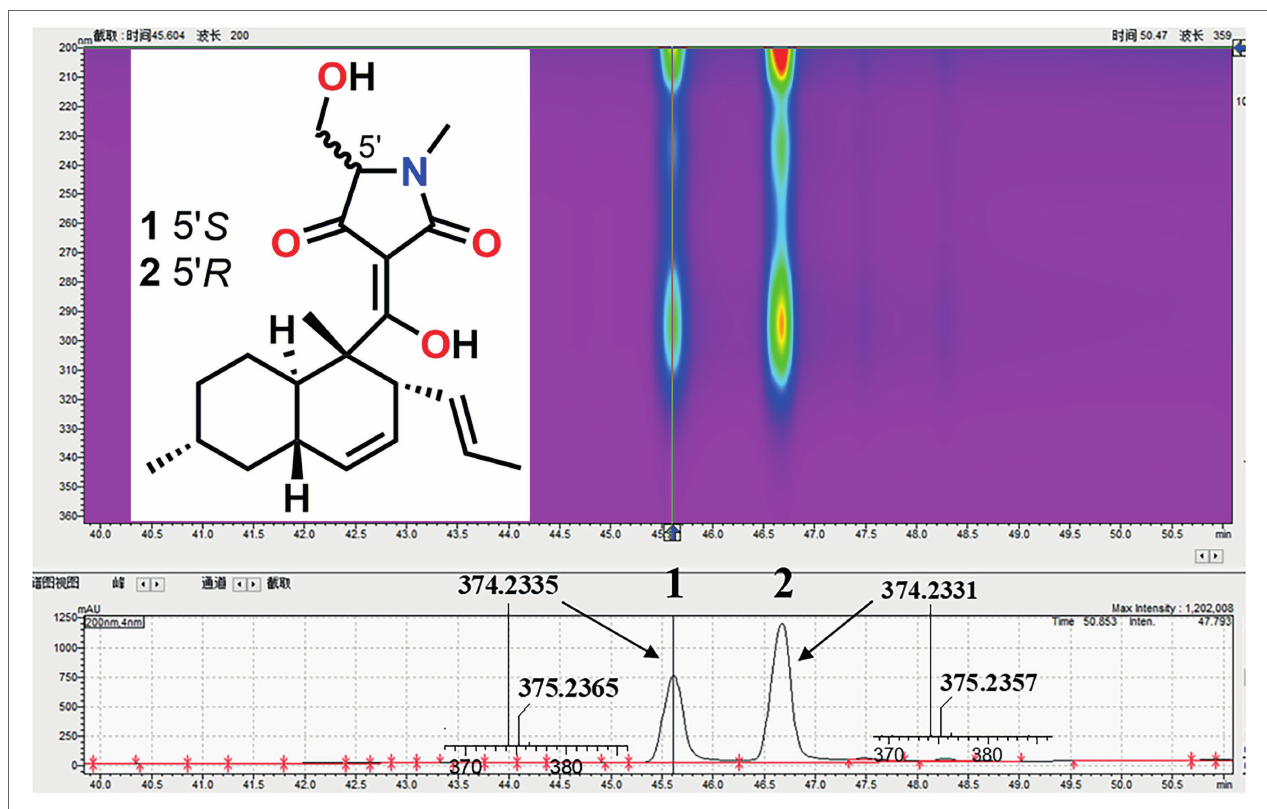
FIGURE 2 | The isolation and structures of equisetin ( 1 ) and 5 ′ -epiequisetin ( 2 ).